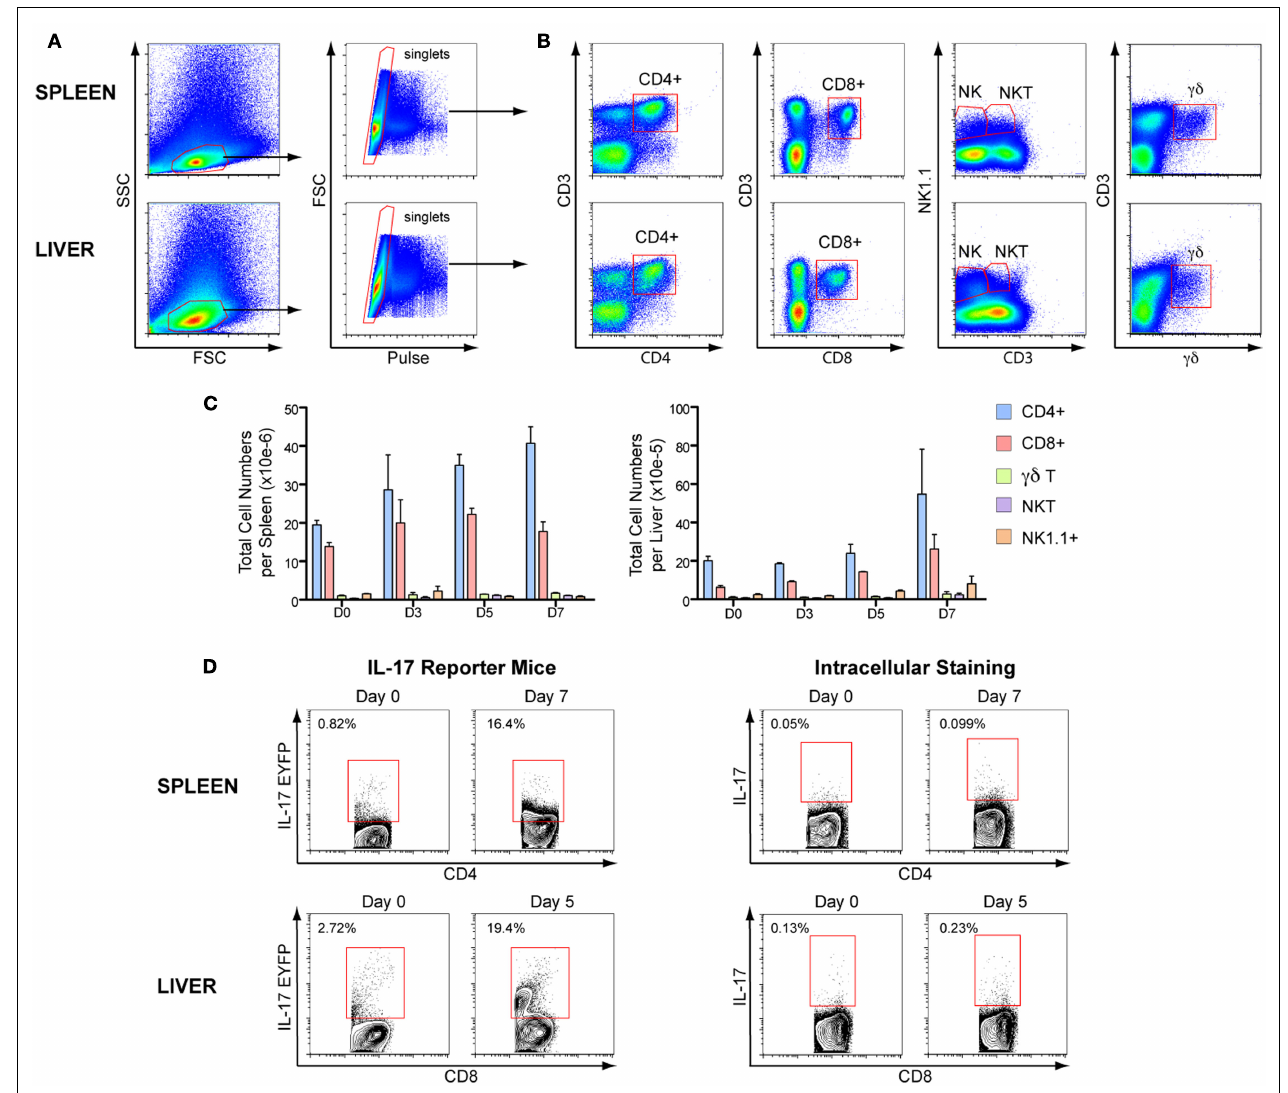
FIGURE 2 | Gating strategies for IL-17 producing cells. IL-17-fate reporter (Il17a Cre R26R eYFP ) and C57BL/6 mice were infected with 10 5 P. chabaudi and sacrificed at days 3, 5, and 7 post-infection. (A) Representative flow cytometry plots of live cells gating in spleen and liver mononuclear cells. (B) Gating strategy for CD3 + , CD4 + , CD8 + , NK + , and γδ + T cells, and CD3 − NK +